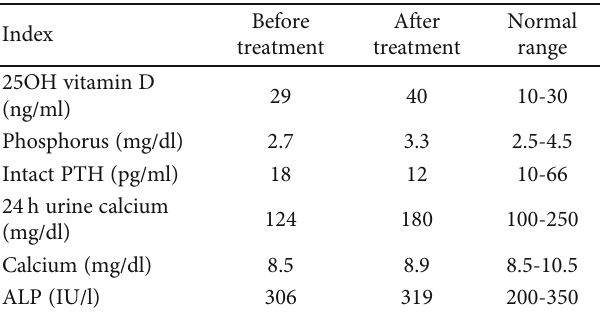
Table 1: Laboratory markers before and 18 months after treatment.